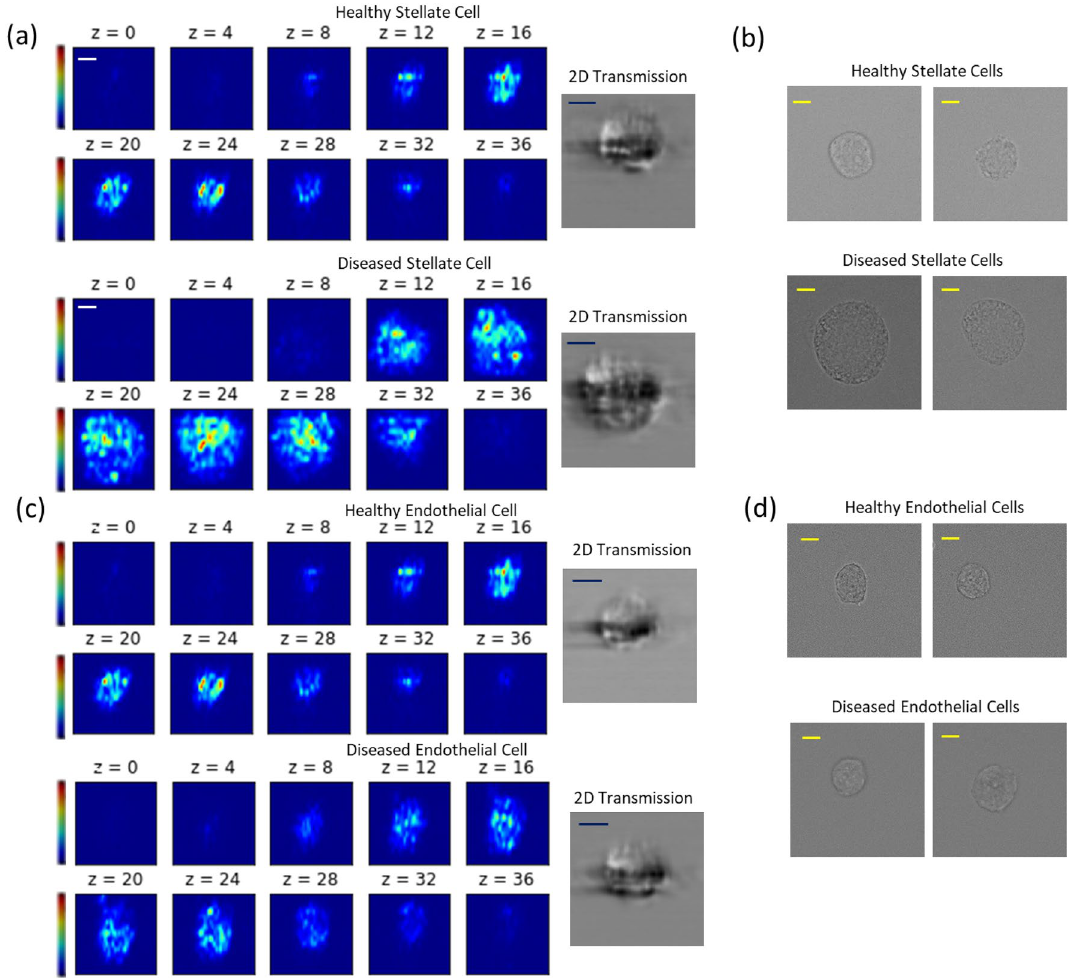
Figure 2. 2D transmission and 3D SSC images of liver cells by 3D-IFC. ( a ) Example 3D SSC image stacks of healthy and diseased HSC cells and corresponding 2D transmission images. ( b ) Example microscope images of healthy and diseased HSC cells. ( c ) Example 3D SSC image stacks of healthy and diseased LEC cells and corresponding 2D transmission images. ( d ) Example microscope images of healthy and diseased LEC cells. Scale bar: 10